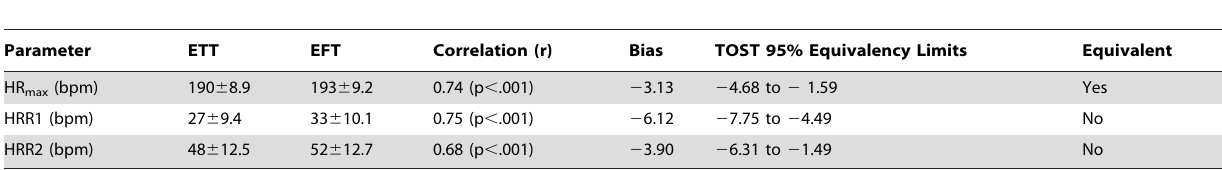
Table 5. Heart rate parameters obtained by the HRM during the ETT and EFT (means 6 SD), correlation between ETT and EFT, bias, and two one-sided test (TOST) equivalency